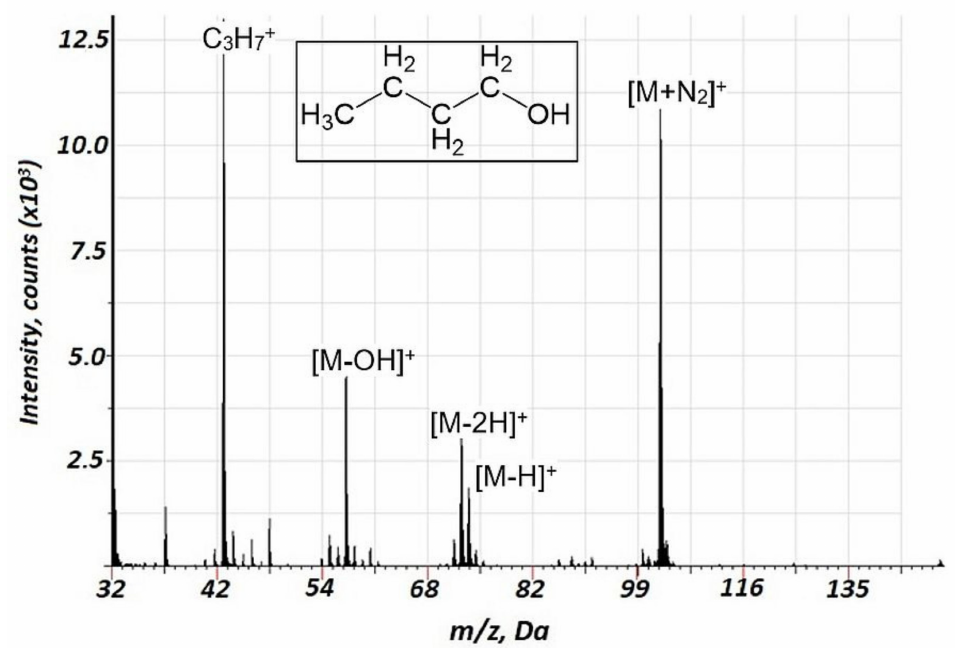
Figure 3. Background corrected mass spectrum range for butanol-1 obtained in air glow discharge. Acquisition parameters were as follows: discharge pulse duration 1.2 µ s, discharge period 700 µ s,